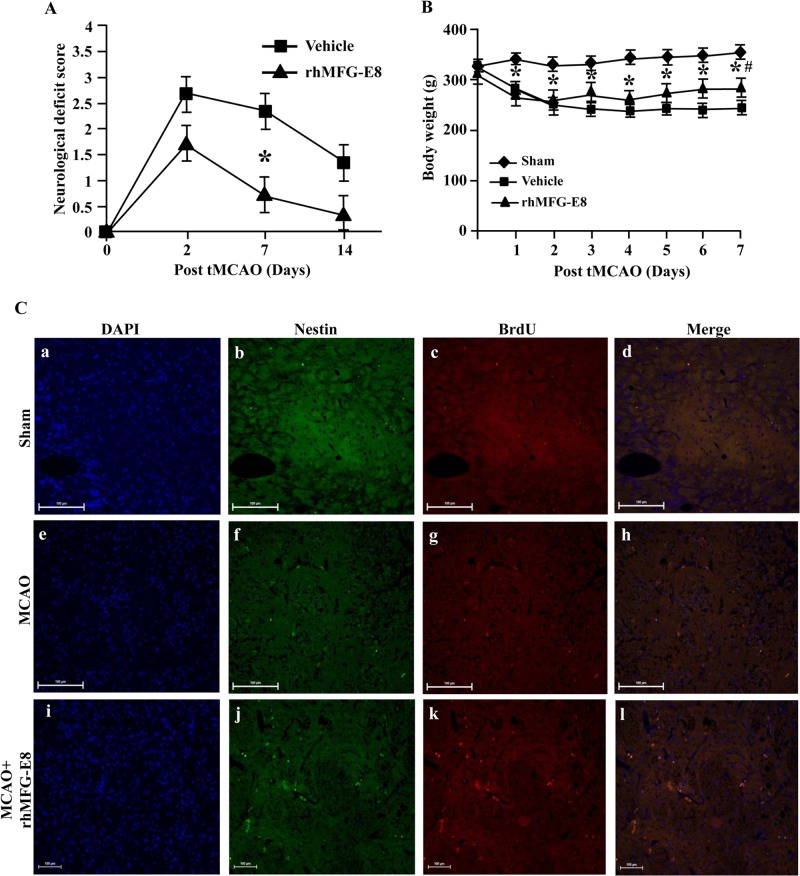
rhMFG-E8 promotes neurological recovery and neural stem cell proliferation after cerebral ischemia.(A) Treatment of rats with rhMFG-E8 significantly decreased neurological deficits at 7 days post-transient middle cerebral artery occlusion (tMCAO) compared with vehicle. Data are presented as mean ± SEM; n = 3 mice/group. The statistical analysis was done by One way Anova and Student-Newman-Keuls (SNK) test. *p<0.05 is considered as statistically significant. (B) Body weight changes of rats within 7 days after tMCAO. Both vehicle and rhMFG-E8-treated groups started to lose weight until day 2 post-tMCAO, at which point the weight of vehicle animals plateaued and rhMFG-E8-treated animals begun to gain weight slowly. Data are presented as mean ± SEM; n = 3 mice/group. The statistical analysis was done by One way Anova and Student-Newman-Keuls (SNK) test. *p<0.05 vs sham; #p<0.05 vs vehicle. (C) The striatum of sham rats (a-d) shows very little baseline neural stem cell proliferative activity as shown by BrdU+Nestin+ cells. At 7 days post-tMCAO, compared with the vehicle treated animals (e-h), rhMFG-E8 treated rats showed increased number of proliferating neural stem cells (i-l). Scale bar = 100 μm.